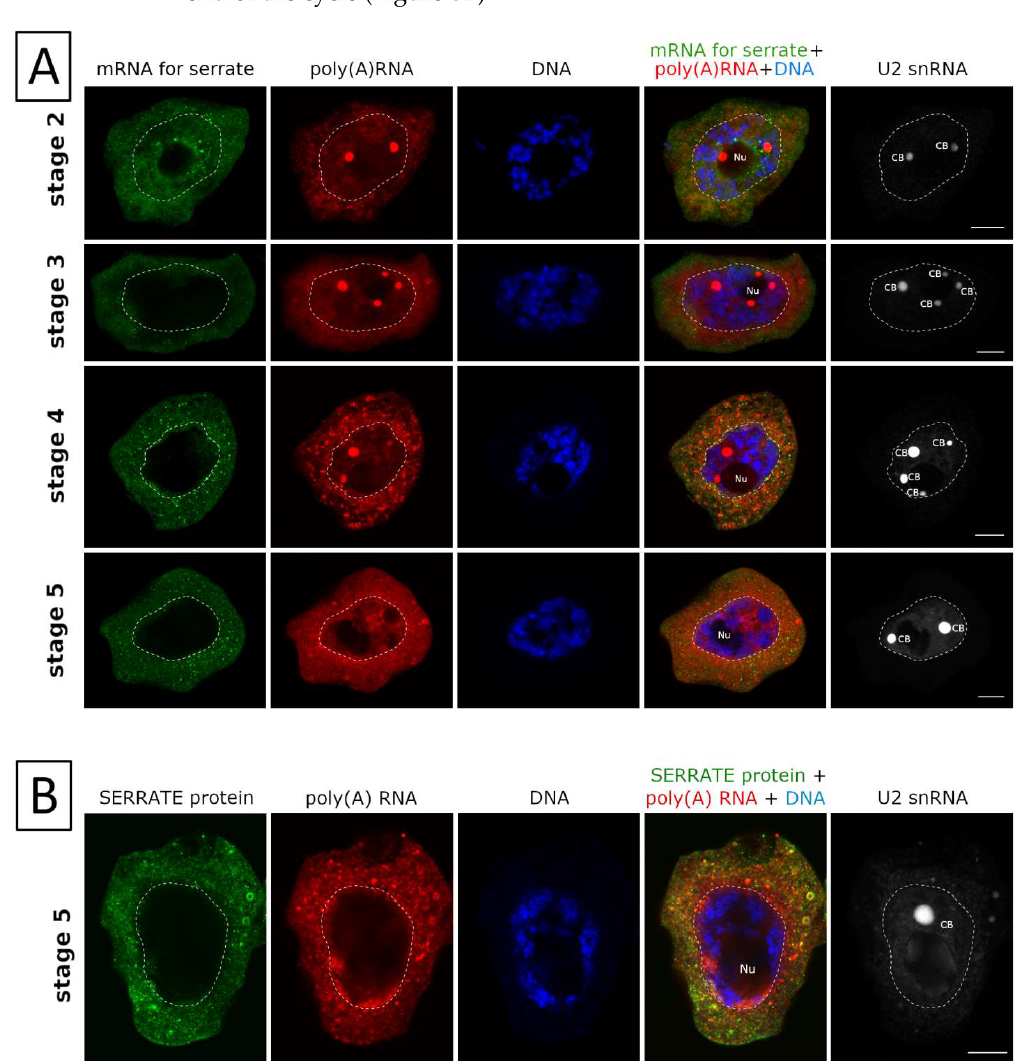
Figure 6. Analysis of SERRATE mRNA and SERRATE protein during poly(A) RNA cycle.(A) SERRATE mRNA (green) is retained in the nucleus until the second stage of the poly(A) cycle and is rapidly exported to the cytoplasm at the beginning of stage 3. The mRNA is present in the cytoplasm until the end of the cycle. (B)Retained mRNAs are exported to the cytoplasm and translated at the end of the cycle. SERRATE proteins are formed in the cytoplasm in large amounts, from the mRNA pool that was processed in the cycle. Nu—nucleolus, CB—Cajal body. Bar—10 µ